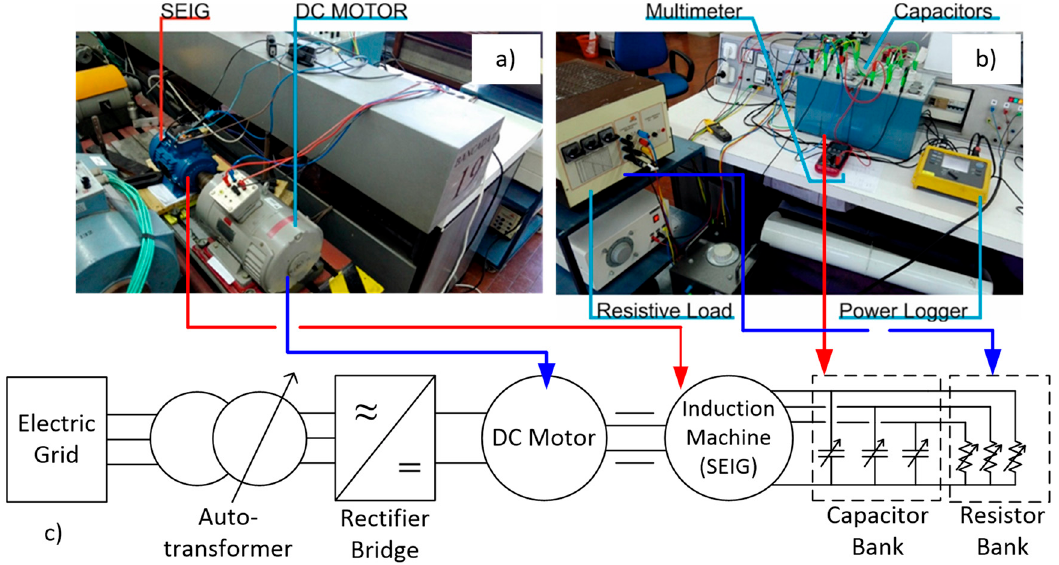
Figure 9. Experimental setup to test the SEIG, isolated from the PAT: ( a ) DC motor coupled mechanically to the SEIG, ( b ) variable capacitor and resistor banks both connected in parallel to the stator coils of the induction generator, ( c ) scheme of two experimental setup components.